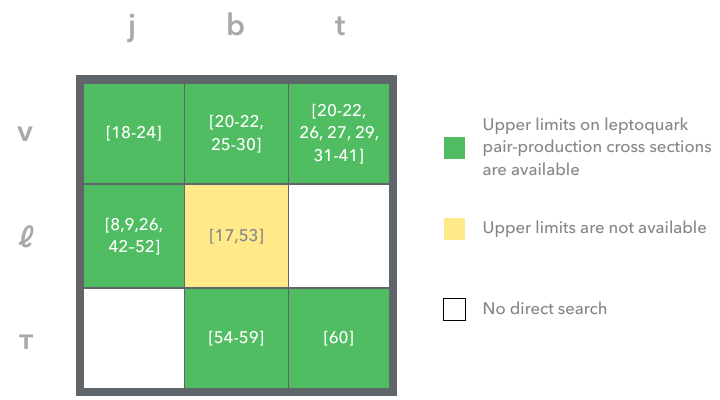
Figure 6 . Summary of the current status of LQ searches at LHC after Runs 1 and 2. We include LQ searches and SUSY searches which have identical (cid:12)nal states and decay topologies to LQ searches. Final states without any direct search are left white. The numbers give the references relevant to the various (cid:12)nal states: ( (cid:23)j ) [18{24], ( (cid:23)b ) [20{22, 25{30], ( (cid:23)t ) [20{22, 26, 27, 29, 31{41], ( ej ) and/or ( (cid:22)j ) [8, 9, 26, 42{52], ( eb ) and ( (cid:22)b ) [17, 53], ( (cid:28)b ) [54{59], and ( (cid:28)t )